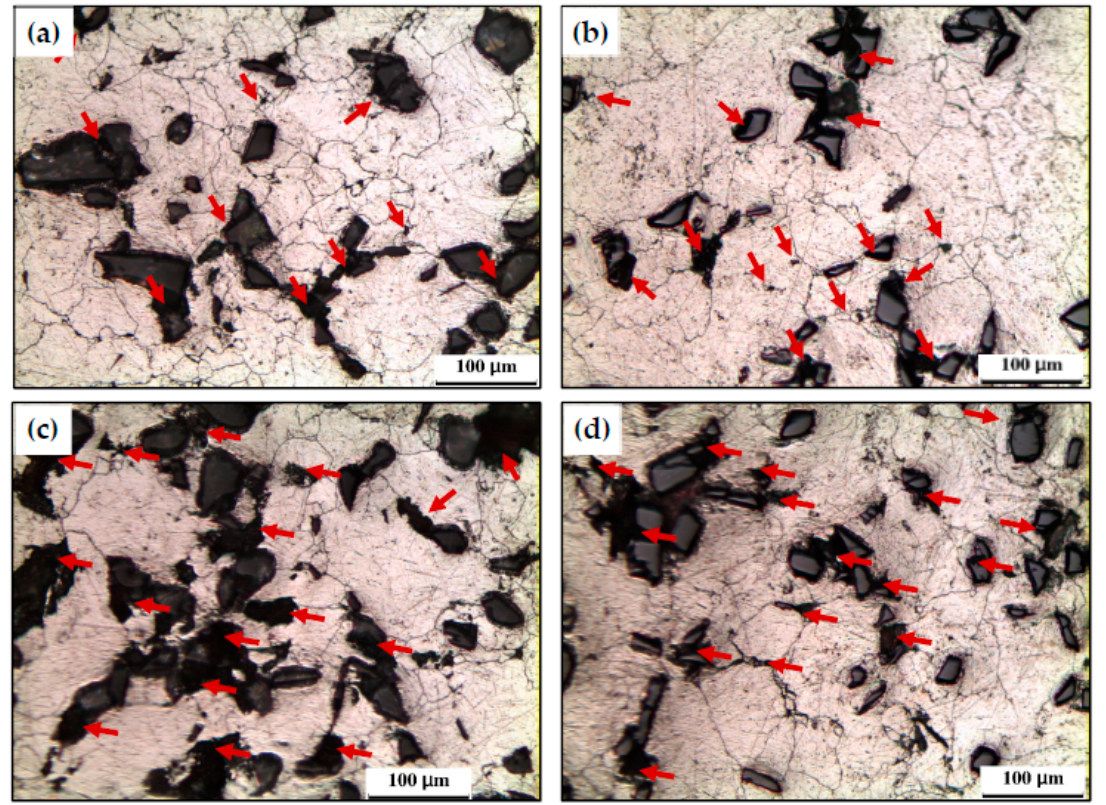
Figure 5. Optical microscope micrographs of PM ( a ) Al-10% Al 2 O 3 , ( b ) Al-10% SiC, ( c ) Al-20% Al 2 O 3 , and ( d ) Al-20% SiC samples.